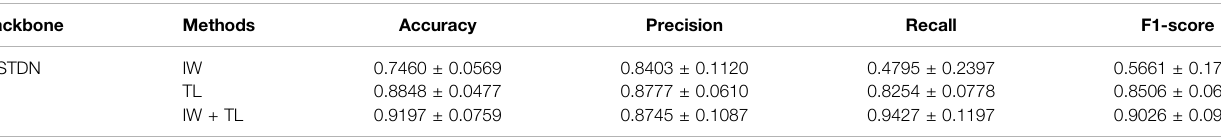
TABLE 3 | Performance of ablation study in the proposed WSTDN